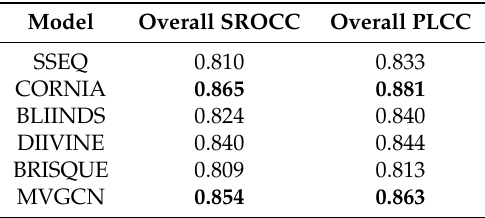
Table 4. Aggregate results of database independent tests for various IQA models. The best two NR IQA models are boldfaced.